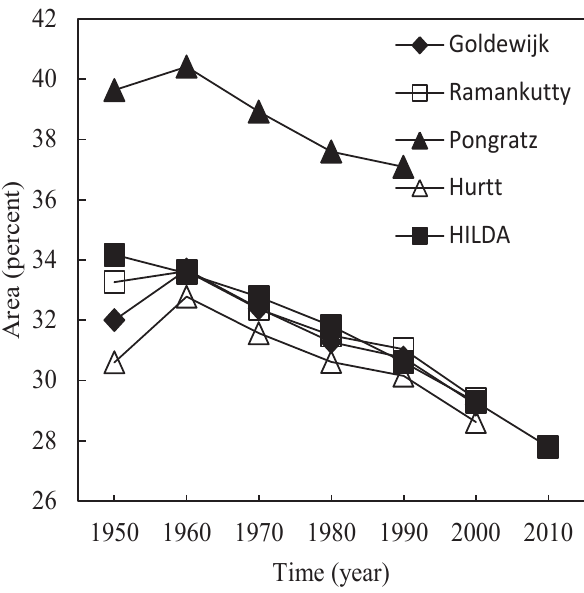
Fig. 8. Area fractions for cropland, compared in decadal time steps from 1950 to 2010 for EU27+Switzerland.